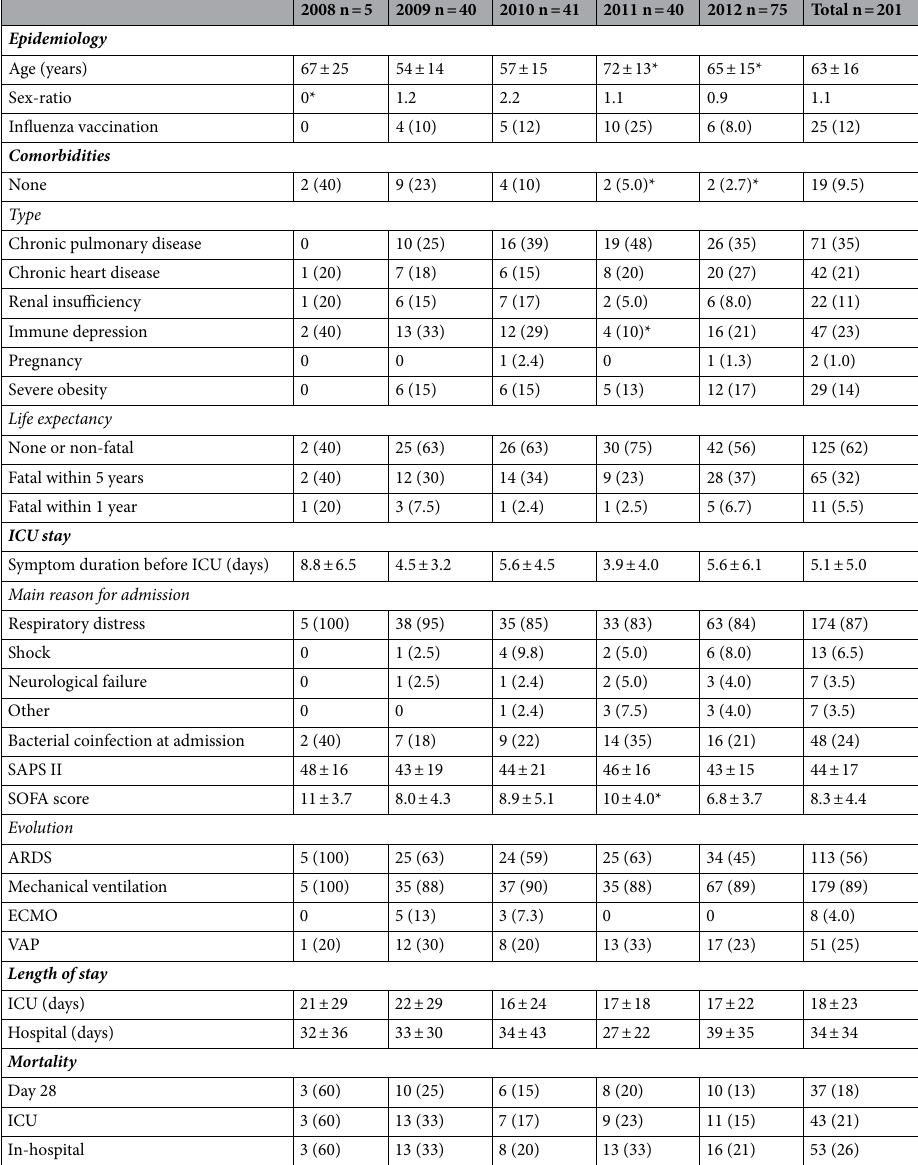
Syndrome; ECMO: Extra-Corporeal Membrane Oxygenation; SOFA: Sepsis-Related Organ Failure Assessment; VAP : Ventilator-Associated Pneumonia. * p < 0.05 versus